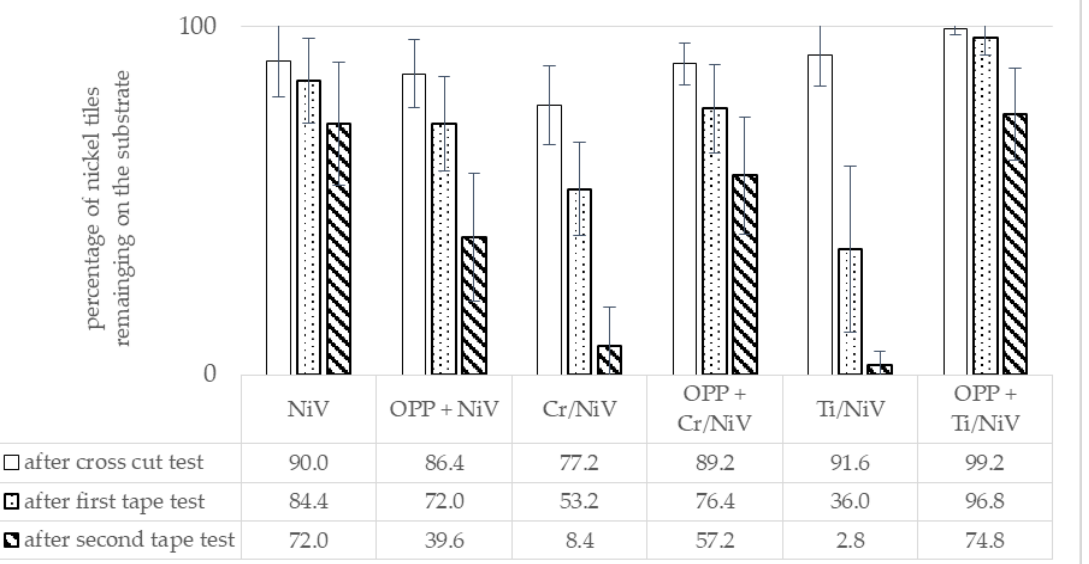
Figure 3. Results of the cross-cut and tape-tests for investigated combinations of adhesion promoting layer and oxygen plasma pretreatment (OPP). The columns represent the amount of nickel tiles remaining on the substrate after each test. Error bars represent the 95% confidence interval.